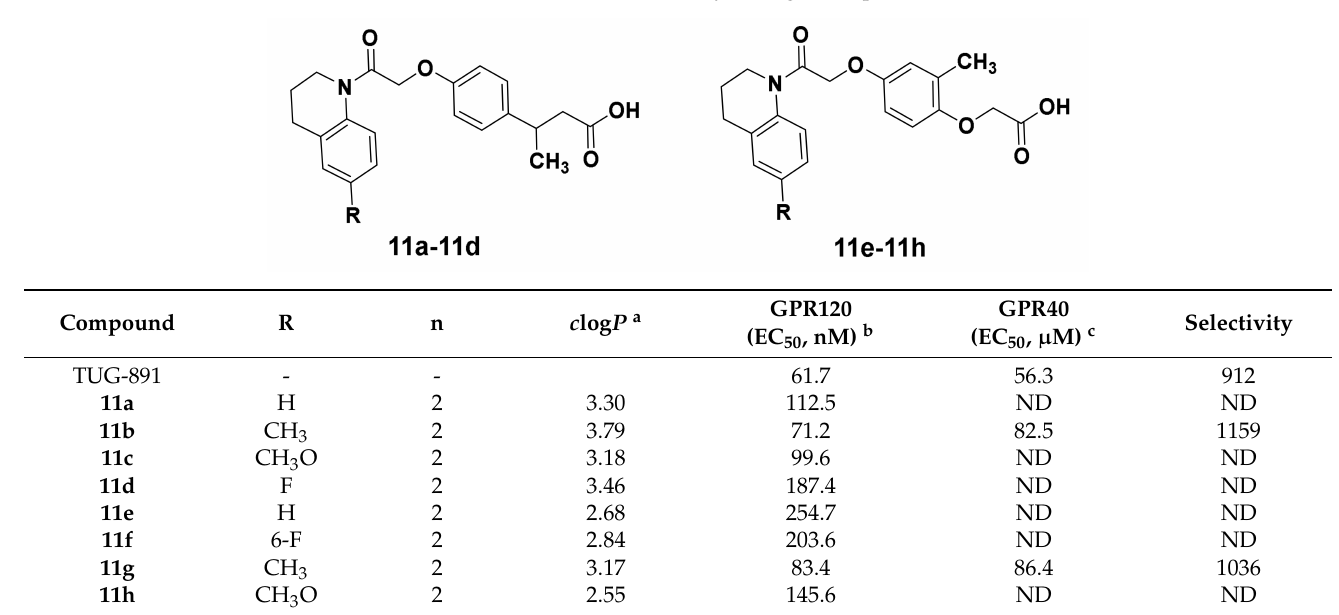
Table 2. In vitro activities and selectivity of target compounds 11a – 11h .